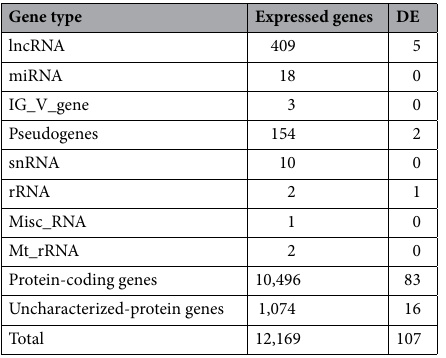
Table 1. Characterization of the articular cartilage transcriptome showing the total number of expressed genes and the differentially expressed ones, according to Ensembl 95 gene type